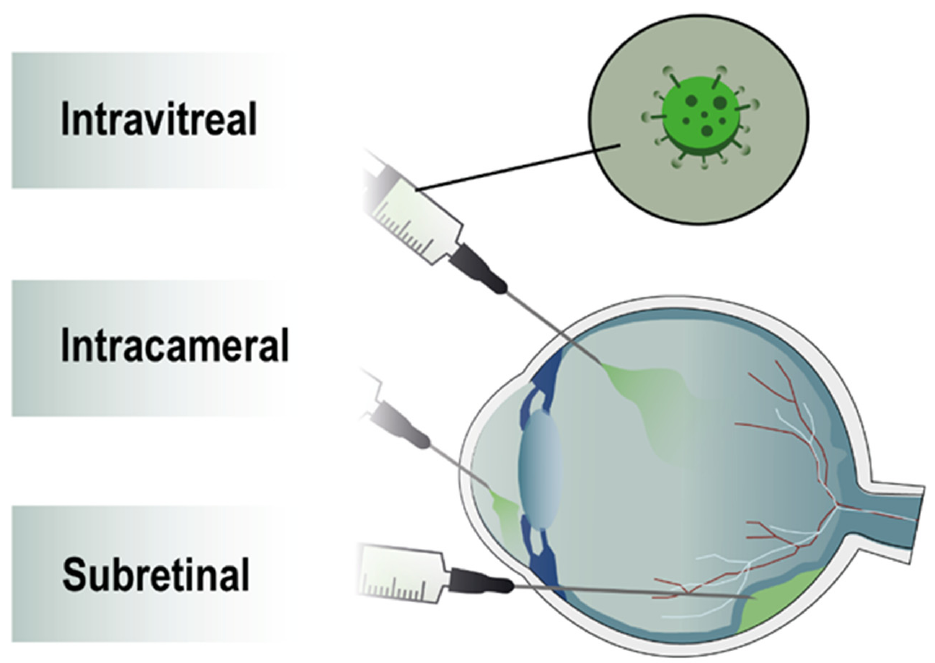
Figure 3. Ocular administration routes. Lentiviral vectors are delivered in the eye using three main routes: intravitreal injection in the vitreous humor to target the ganglion cell layer, intracameral injection in the aqueous humor to target the trabecular meshwork, and subretinal injection between the neuroretina and the RPE to reach RPE and photoreceptors.